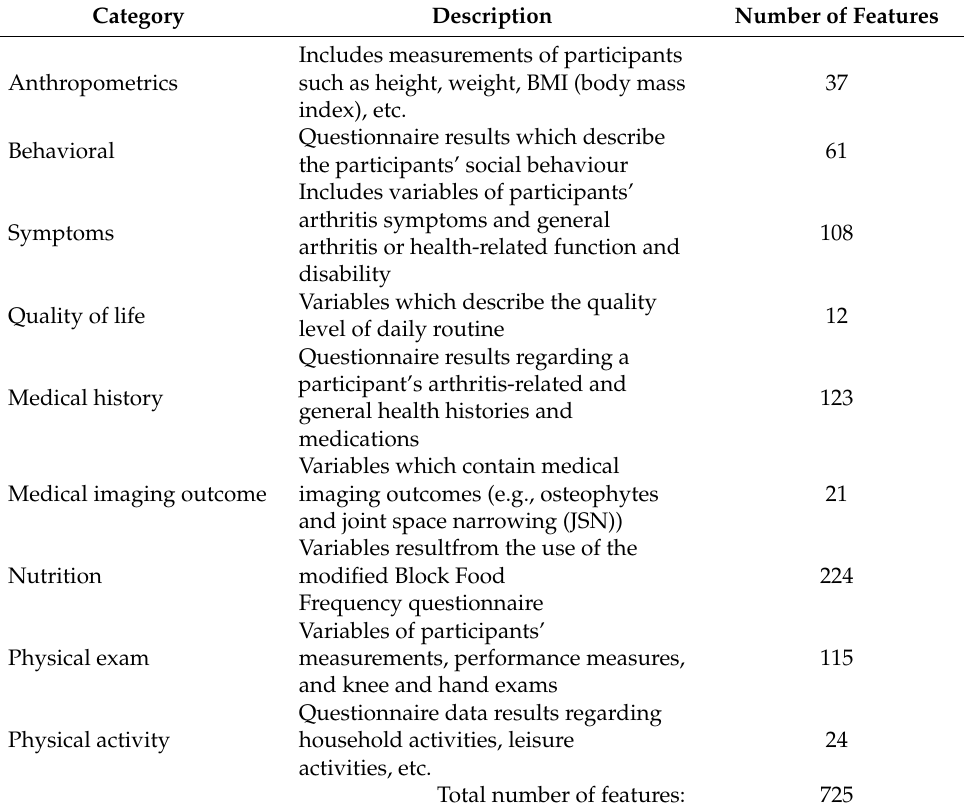
Table 1. Maim categories of the feature subsets considered in the proposed